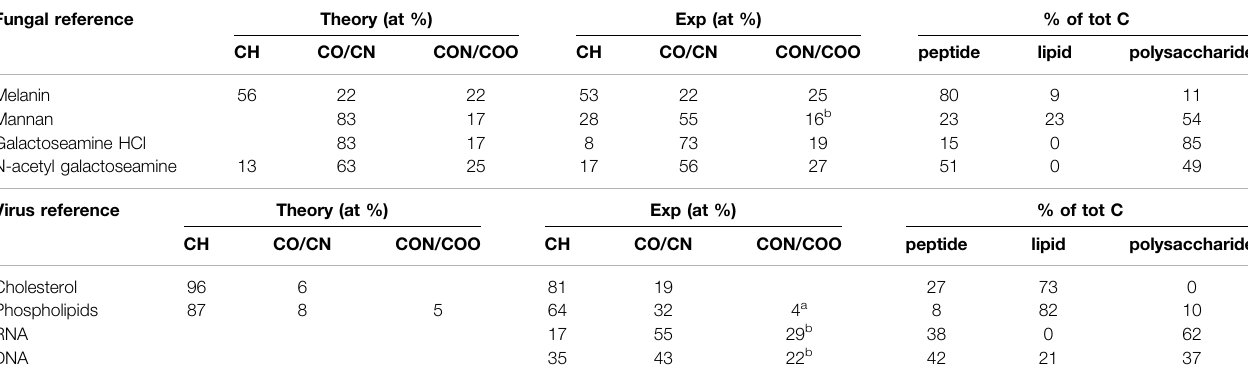
TABLE 2 | Data from fi tting of C1s spectra from reference samples using Gaussian-Lorentzian (GL30) peak shapes and spectral components. Fungal